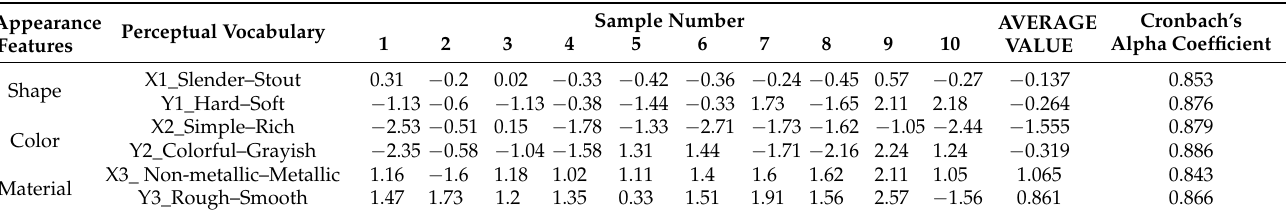
Table 2. Correlation scores between perceptual vocabulary and sample